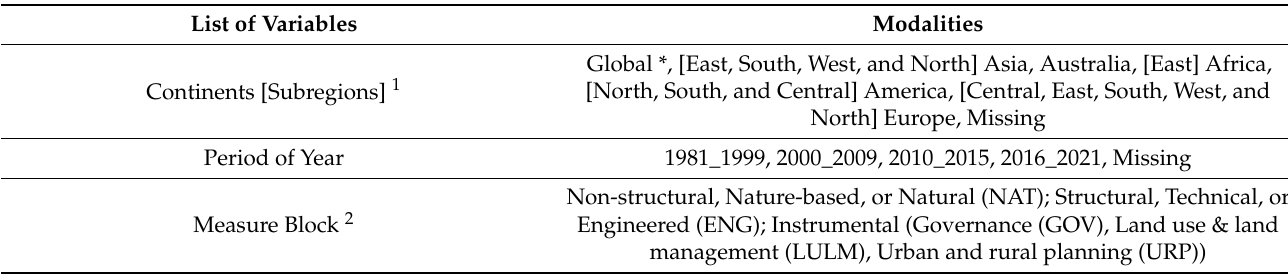
Table 1. List of flood management (FM) solutions used in the expert survey and literature description, with abbreviations and examples in